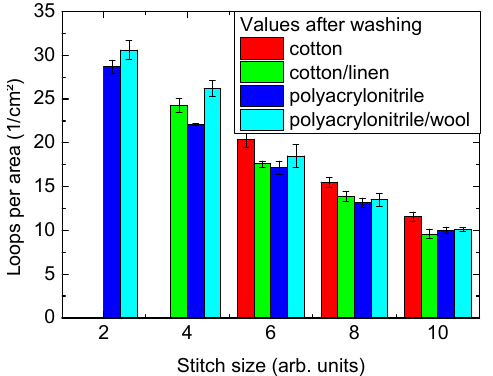
Figure 1. Numbers of loops per area, measured after washing using microscopic images of areas (11 mm × 15 mm). The stitch sizes are given by the machine definition, ranging from 1–10. The resulting structural parameters of the knitted fabrics can be found below.